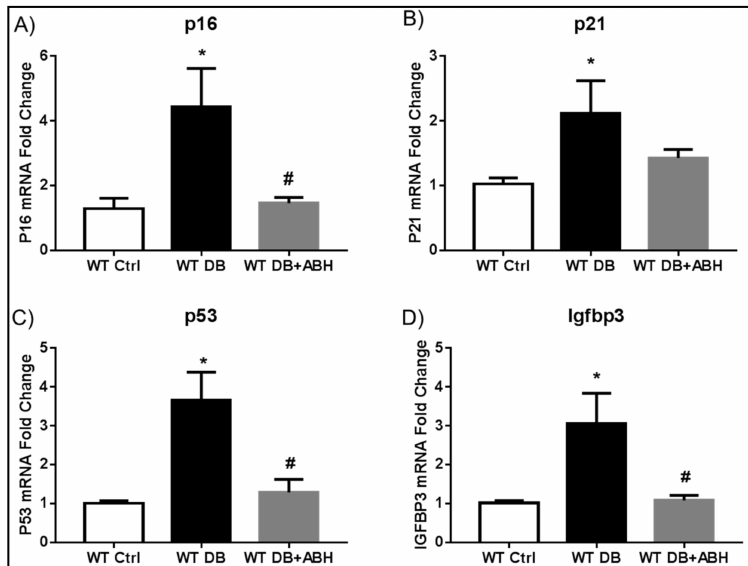
Figure 3. Arginase inhibition prevents diabetes-induced alterations in retinal senescence markers. qRT-PCR showing increased mRNA levels of p16 ( A ); p21 ( B ) p53 ( C ); and, Igfbp3 ( D ) in the diabetic retinas compared to age matched controls. 2(S)-Amino-6-boronohexanoic acid (ABH) treatment significantly blocked the diabetes-induced senescence. * p < 0.05 vs. WT Ctrl, # p < 0.05 vs. WT DB. n = 4–9.